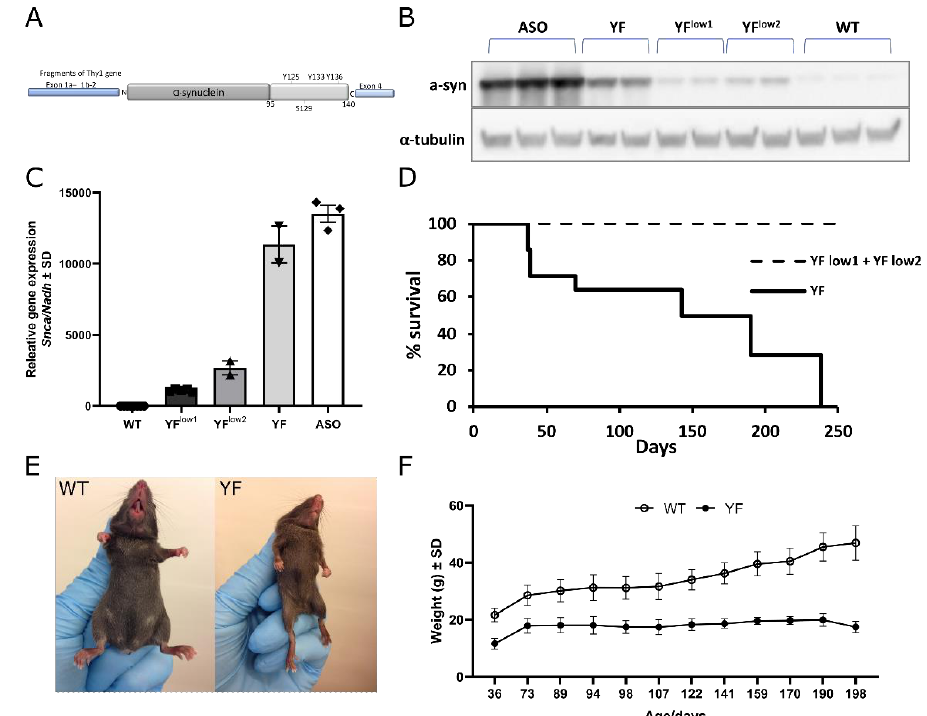
Figure 1. Lack of tyrosine phosphorylation is toxic in a mouse model. ( A ). Generation of human α -synuclein YF transgenic mouse lines by insertion of α -synuclein with three mutated tyrosines (125, 133, and 136) for phenylalanine downstream of the Thy1 promoter. The DNA was inserted into the mouse genome by pronucleus injection. YF mouse lines were generated with the mThy1.2 cassette as the ASO mouse line [15]. ( B ). Western Blotting of whole brain homogenates from ASO mice, mice of the three YF mouse lines, and wildtype (WT) mice. The YF mice have a slightly lower expression level of α -synuclein compared to that of ASO mice. YF low1 has a slightly lower expression than YF low2 ( C ). Relative gene expression of the Snca RNA level in WT, the three different YF mouse lines, and ASO mice compared to the reference gene Nadh . The profile of the expressed RNA levels corresponds to protein levels demonstrated in B. Data are depicted as mean ± SD: WT ( n = 8), YF low1 ( n = 5), YF low2 ( n = 2), YF ( n = 2), and ASO ( n = 3). ( D ). Kaplan–Meyer curve of a cohort of YF mice ( n = 14) compared to YF low1 and YF low2 (both n = 14). YF mice have decreased life span, whereas YF low1 and YF low2 mice have normal life span, even at time points beyond 250 days. YF mice were sacrificed at humane end-points due to motoric difficulties starting at 45 days of age. ( E ). Images of adult WT and YF mice. YF mice are smaller and have a dramatic motoric phenotype seen by paralysis of both hind- and forelegs starting at one month of age. ( F ). YF mice ( n = 7) are significantly smaller than their WT littermates ( n = 10) during the entire experimental period, p < 0.005 for all time points. Nonetheless the YF mice gain some weight. Data are depicted as mean ± standard deviation (SD); as variance was equal for the two experimental groups, the data was analyzed using unpaired t